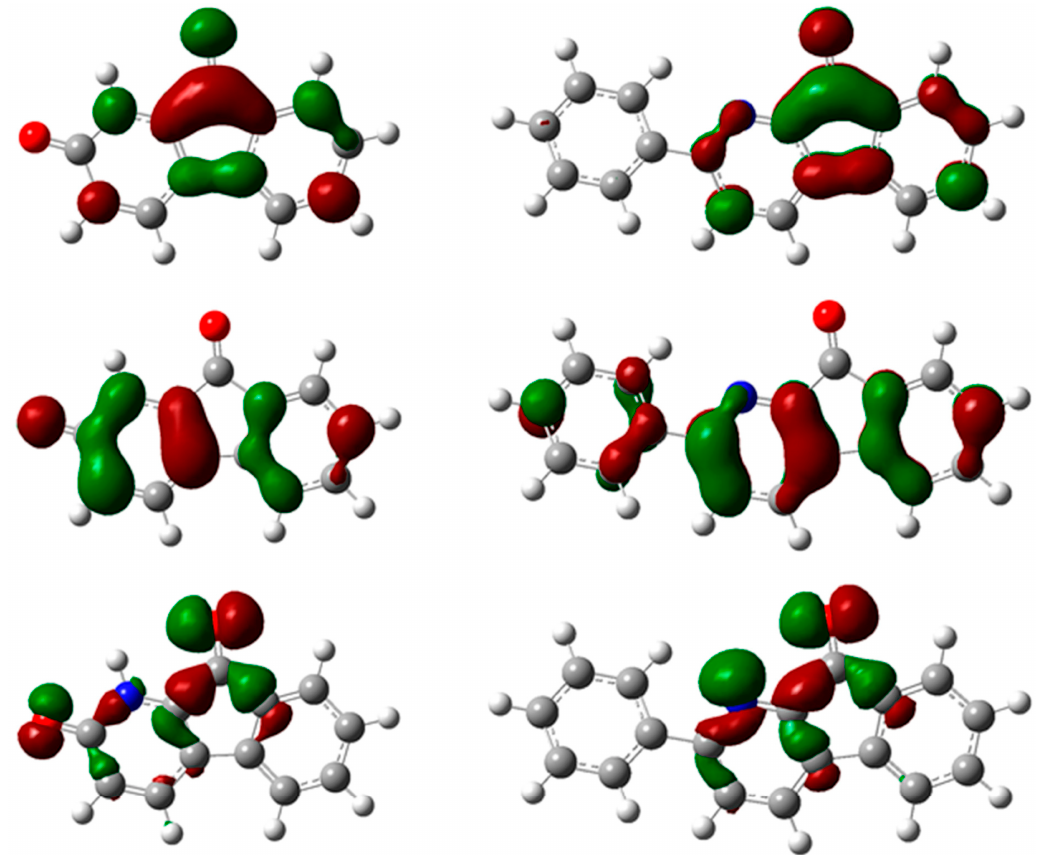
Figure 4. Frontier molecular orbitals (top, LUMO; middle, HOMO; bottom, HOMO-1) for pyridone 10a ( left ) and phenylazafluorenone 11b ( right